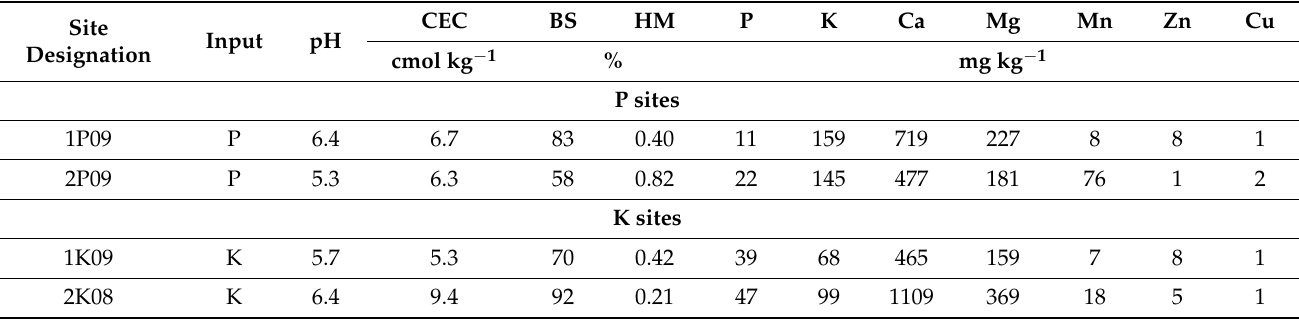
Table 6. Soil properties of sites used in the P and K response studies (2008–2011).